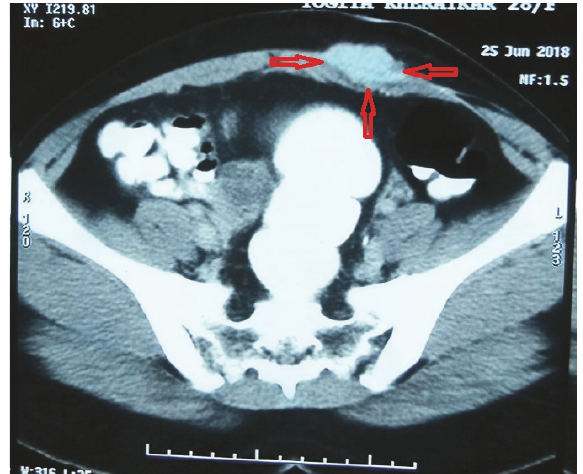
Figure 2: CECT showing enhancing mass in the subcutaneous tissues infiltrating the deeper musculoaponeurotic